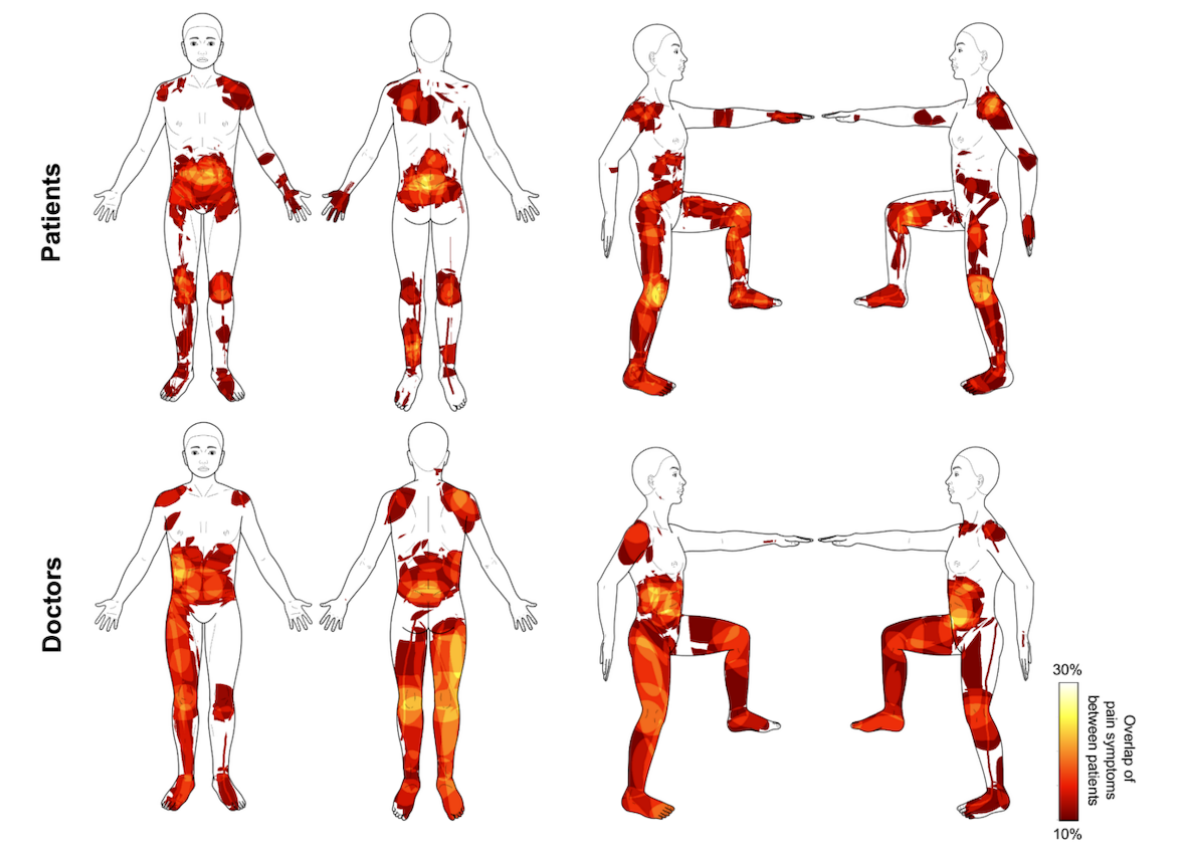
Figure 3. Descriptive comparison of patients’ (top line) and doctors’ (lower line) perception of pain in our final sample of 47 acute pain patients. Average pain distribution thresholded at 10% overlap between patients.